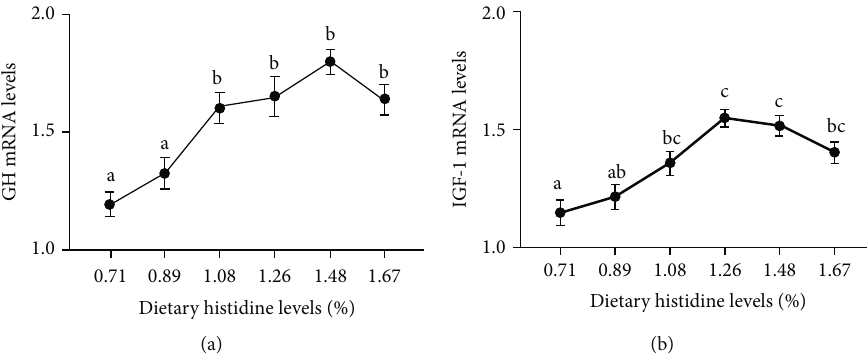
Figure 4: The relative expressions of GH-IGF-1 axis in liver of juvenile largemouth bass fed with di ff erent levels of dietary histidine. Data are expressed as means with S.E.M.; value with di ff erent superscripts are signi fi cantly di ff erent ( P < 0 : 05